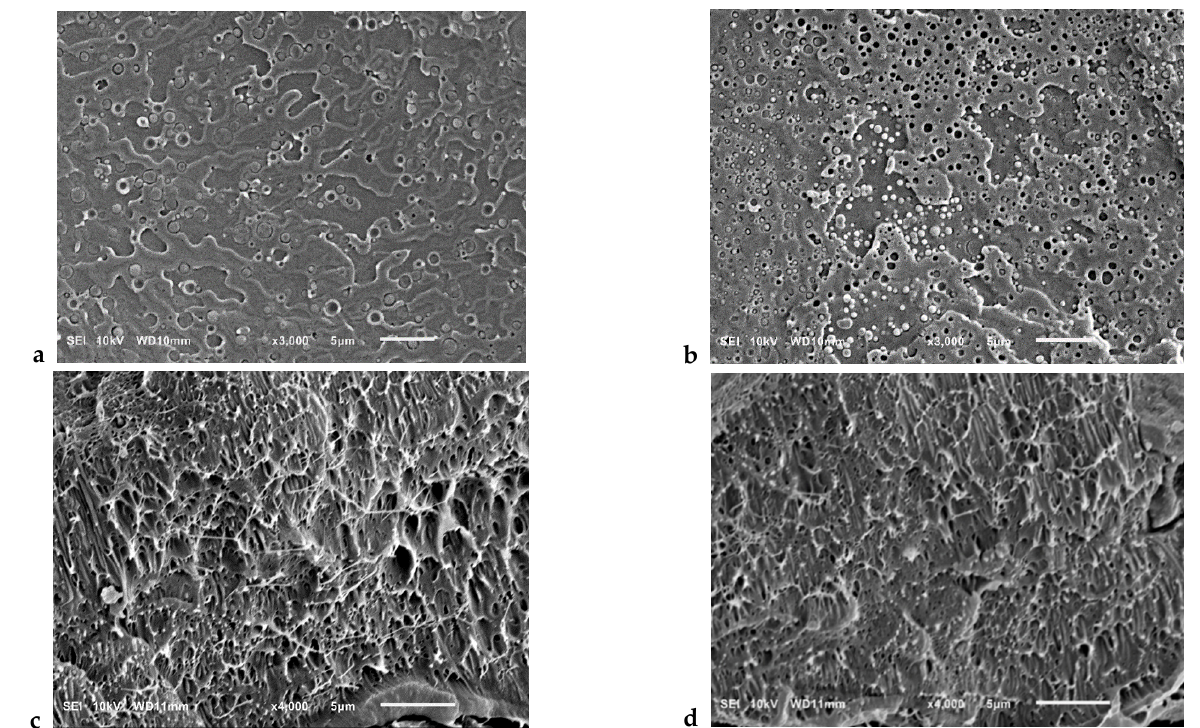
Figure 1. SEM images of cryofracture surfaces of PLA/PBAT/CNFs blends ( a , b ) and in situ generated composites ( c , d ). ( a , c )—3wt.%CNFs, ( b , d )—7wt.%CNFs.